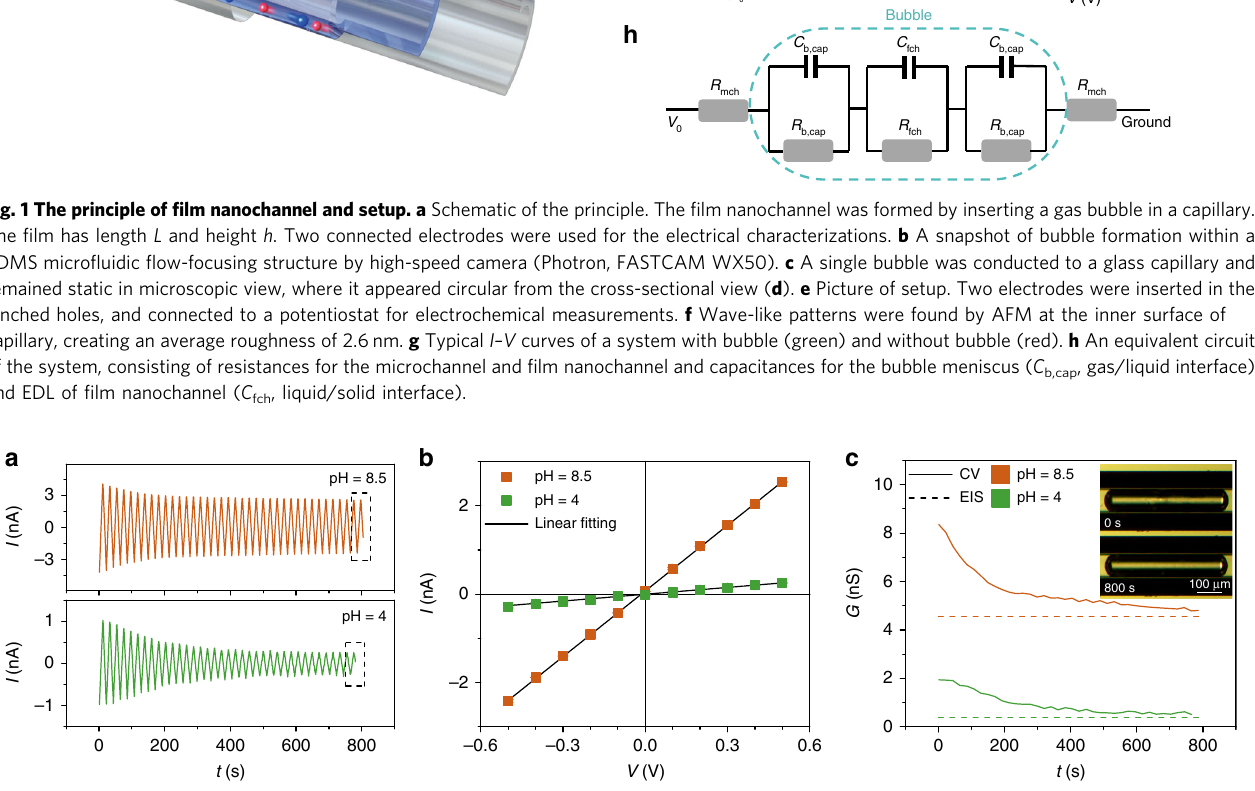
state (Fig. 2c). More details are shown in Supplementary Note 5.